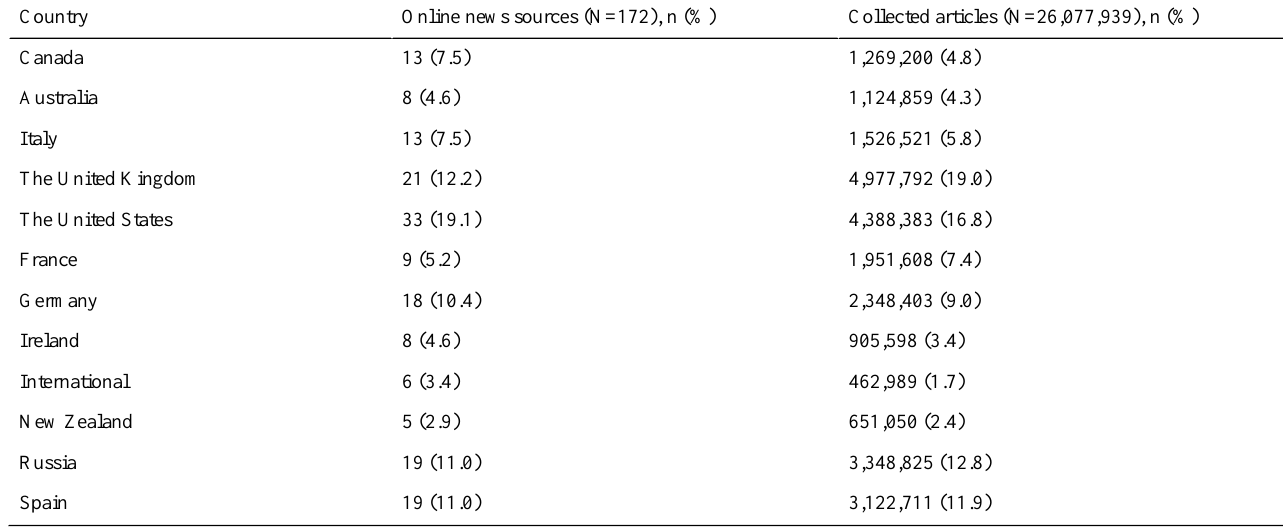
Table 1. Number of online news sources and collected articles per